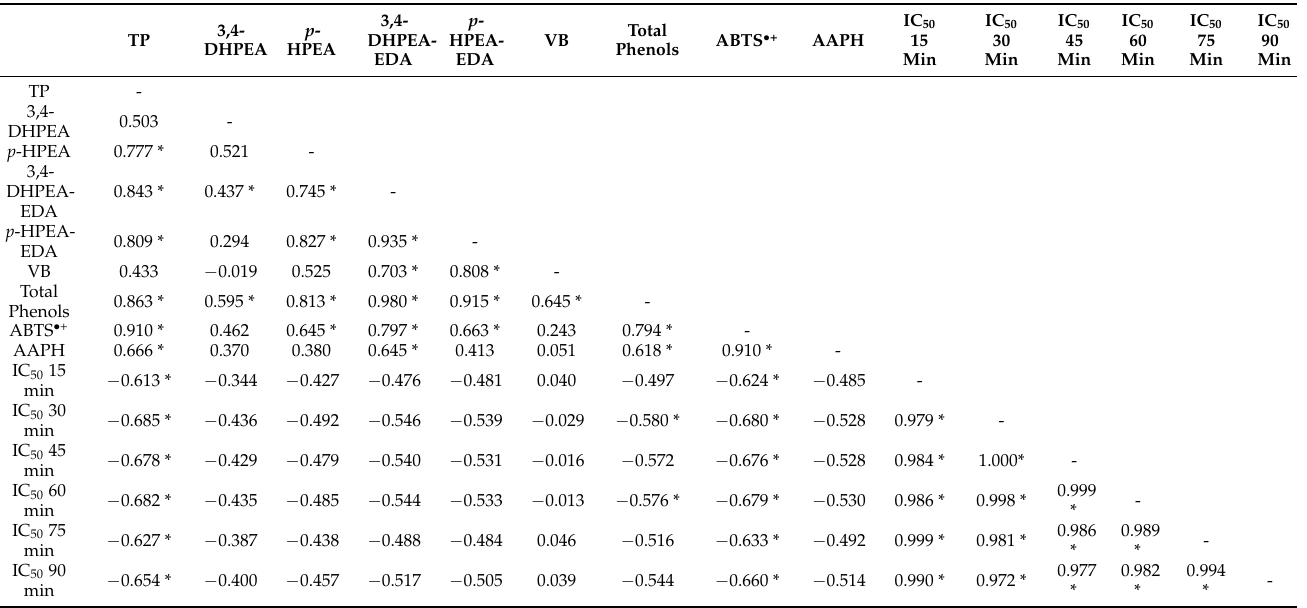
Table 4. Pearson’s correlation matrix among total and single phenols and antioxidant activity of the extracts before and after in vitro